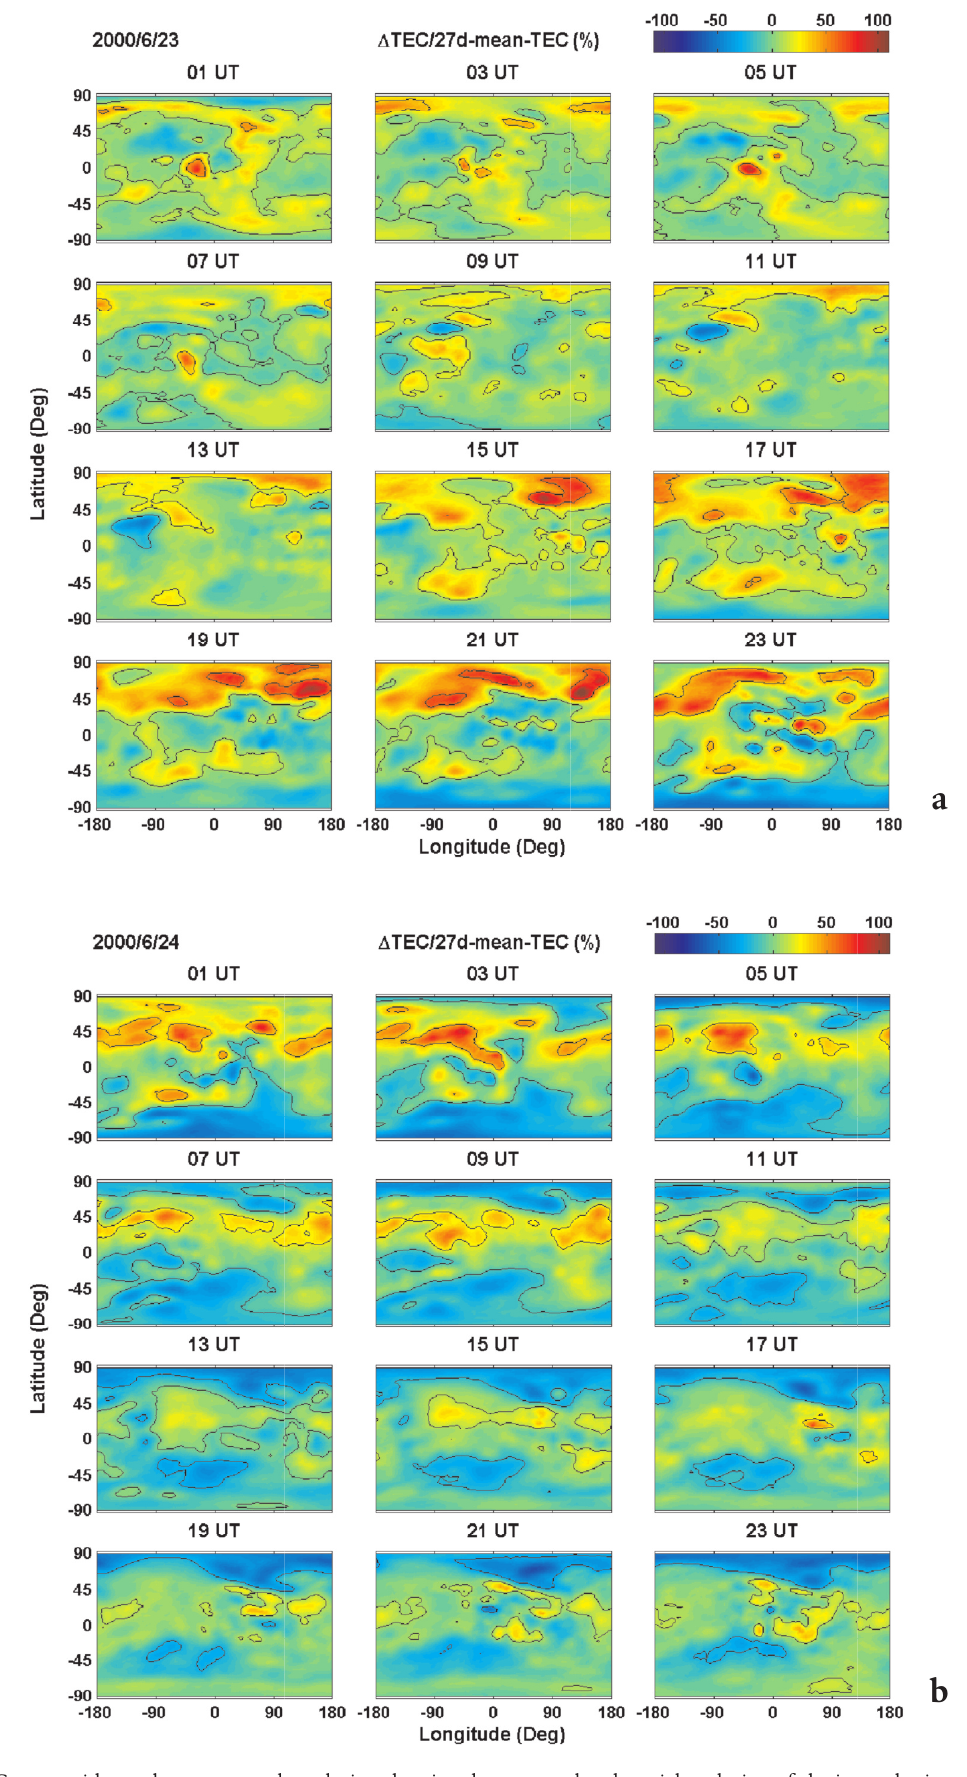
Figure 5. (a) D TEC maps with two-hour temporal resolution showing the temporal and spatial evolution of the ionospheric storm on June 23, 2000. (b) As for (a), for June 24, 2000. (c) As for (a), for June 25, 2000 (see next